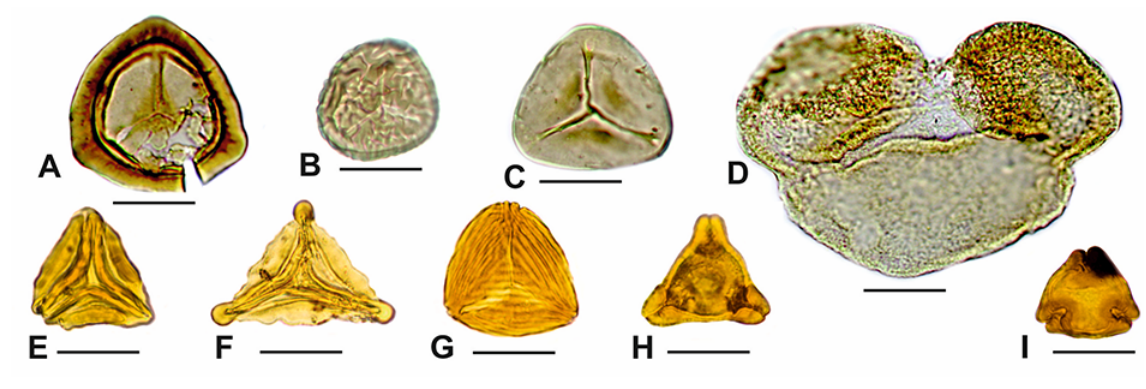
Figure 3 Characteristic spores and pollen grains from the Cretaceous of Poland. ( A ) Cingutriletes sp. spore of bryophyta (Sphagnaceae), Sample 2, Folwark Quarry, Upper Turonian; ( B ) Camarozonosporites sp., spore of Lycopodiaceae, Sample 2, Folwark Quarry, Upper Turonian; ( C ) Deltoidospora sp. fern spore of Cyatheaceae ? or Dicksoniaceae ?, Sample 1, Folwark Quarry, Upper Turonian; ( D ) Pinuspollenites sp. pollen grain of conifers Pinaceae, Sample 3, Folwark Quarry, Upper Turonian; ( E ) Gleicheniidites senonicus Ross, fern spore of Gleicheniaceae, Sample 22, Pełczyska, Lower Maastrichtian; ( F ) Clavifera triplex (Bolkhovitina) Bolkhovitina, fern spore of Gleicheniaceae, sample: Pełcz 23, Pełczyska, Lower Maastrichtian; ( G ) Ruffordiaspora sp., fern spore of Schizaeaceae, Sample: Pełcz 17, Pełczyska, Lower Maastrichtian; ( H ) Normapolles, pollen grain of Fagales, sample: Pełcz 22, Pełczyska, Lower Maastrichtian; ( I ) Trudopollis sp., pollen grain of Fagales, Sample 19, Pełczyska, Lower Maastrichtian. Scale bar: 20 µm. Photos by E. Worobiec ( A–H